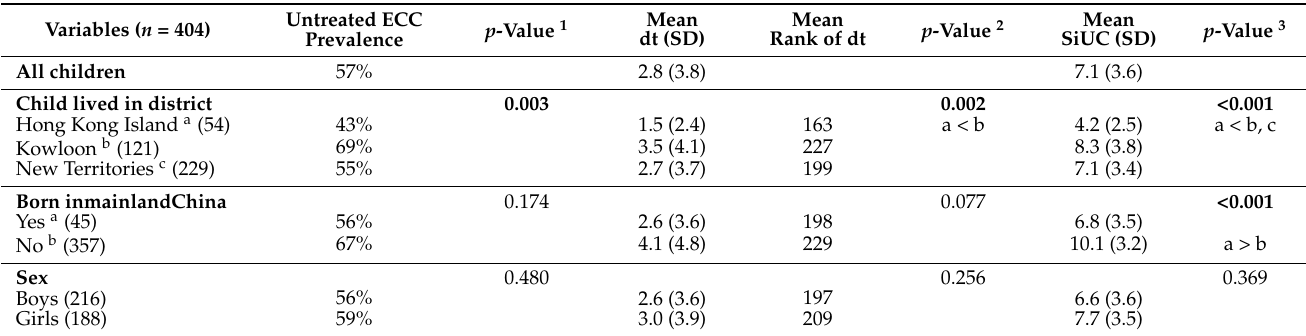
those who were not born in mainland China ( p < 0.001). In addition, our results are most compatible with no important association between children’s sex and untreated ECC prevalence ( p = 0.480), mean rank of dt ( p = 0.256) or mean SiUC index ( p = 0.369). Table 1. Untreated ECC prevalence and significant untreated ECC (SiUC) according to sex, birthplace and district they lived in.